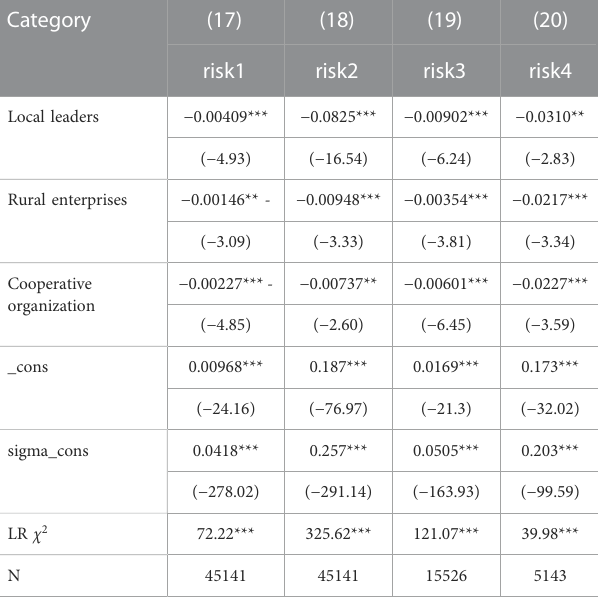
TABLE 8 Tobit regression estimates of social capital variables to re-poverty risk. Category